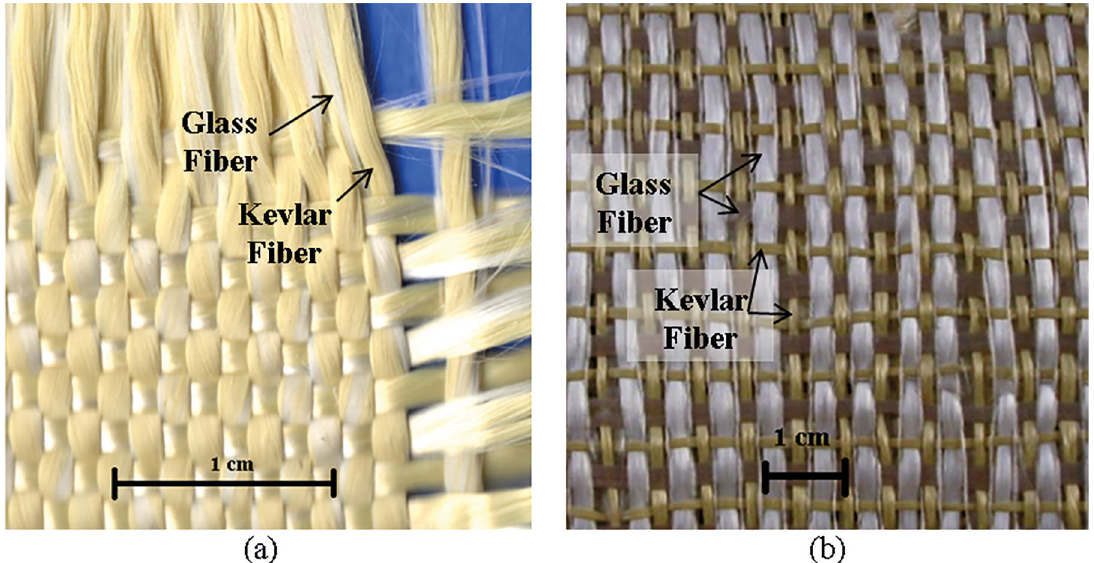
Figure 1. Hybrid fabrics used in the manufacture of laminates; (a) fabric of hybrid strand and (b) hybrid fabric.